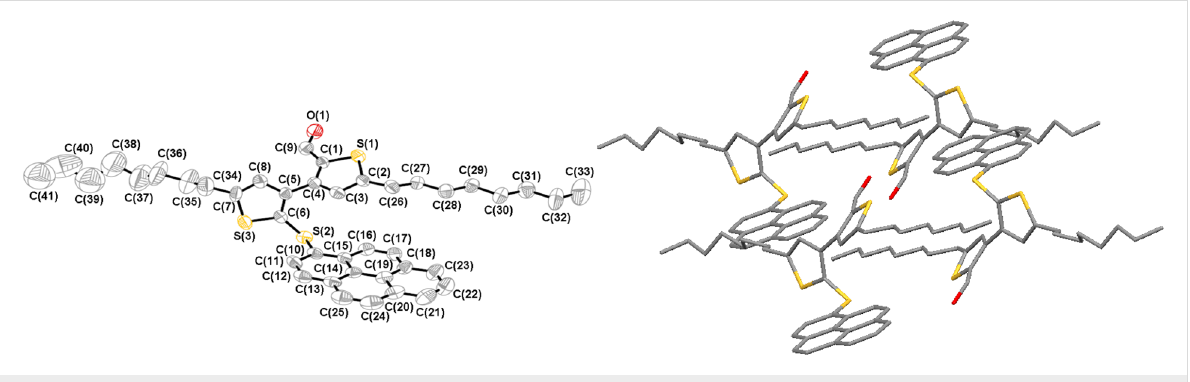
Figure 1: Crystallographic structure of 3i (left, top view) and crystal packing (right). Carbon, silicon, oxygen and sulfur atoms are depicted with thermal ellipsoids set at 50% probability level, and all hydrogen atoms are omitted for